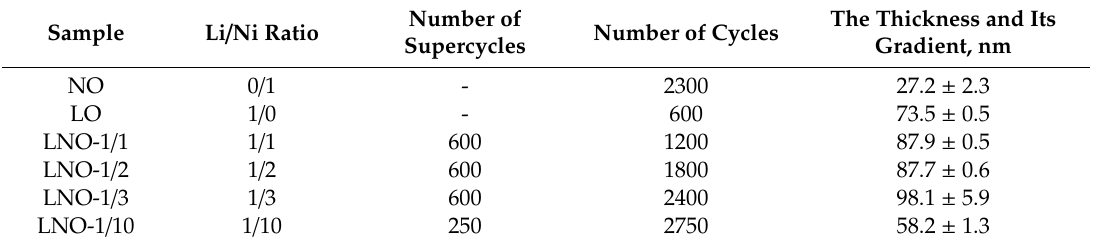
Table 1. List of samples and results of thickness measurements by spectroscopic ellipsometry.